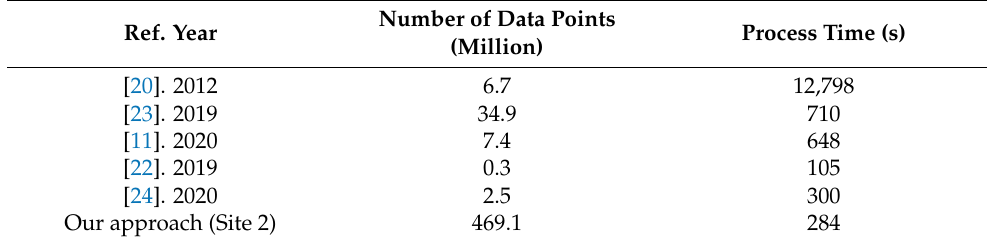
Table 3. Comparison of the most time-consuming cases between our approach and other methods.